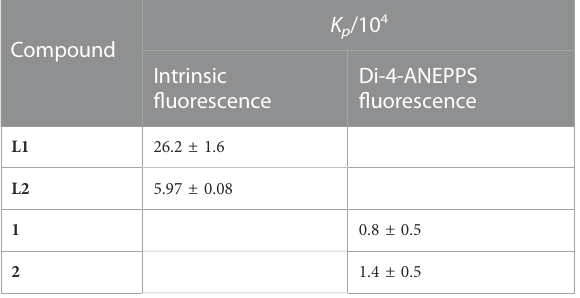
TABLE1Membrane/waterpartitioncoef fi cient( K p )valuesofthecomplexes andligands forDOPC bilayers,calculated usingEq. 6(L1 and L2 )orEq. 12 ( 1 and 2 ) to the experimental